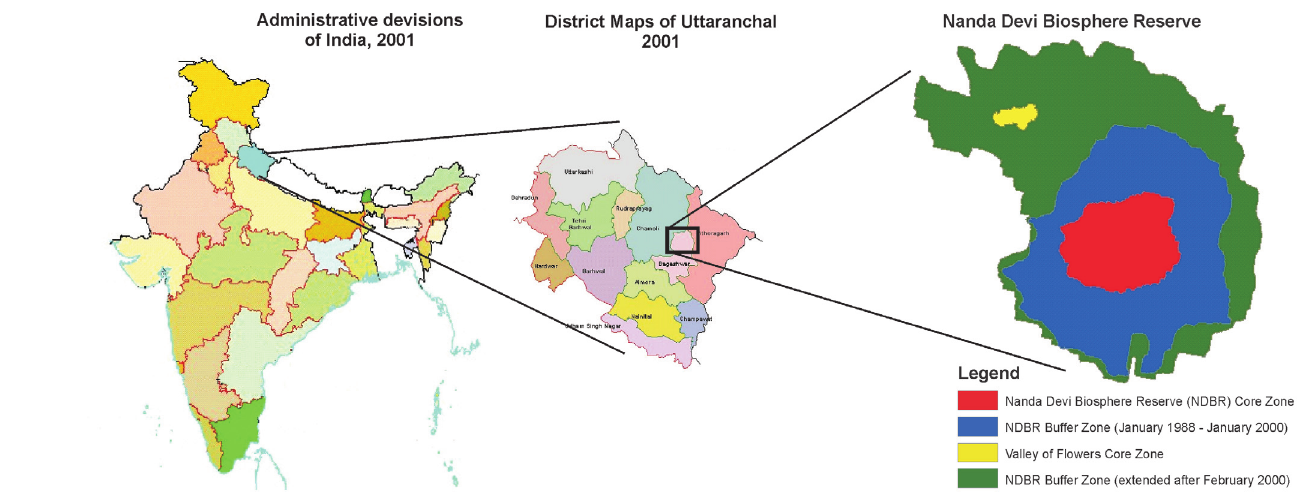
Figure 1: Location of the study area in the Indian Himalayan